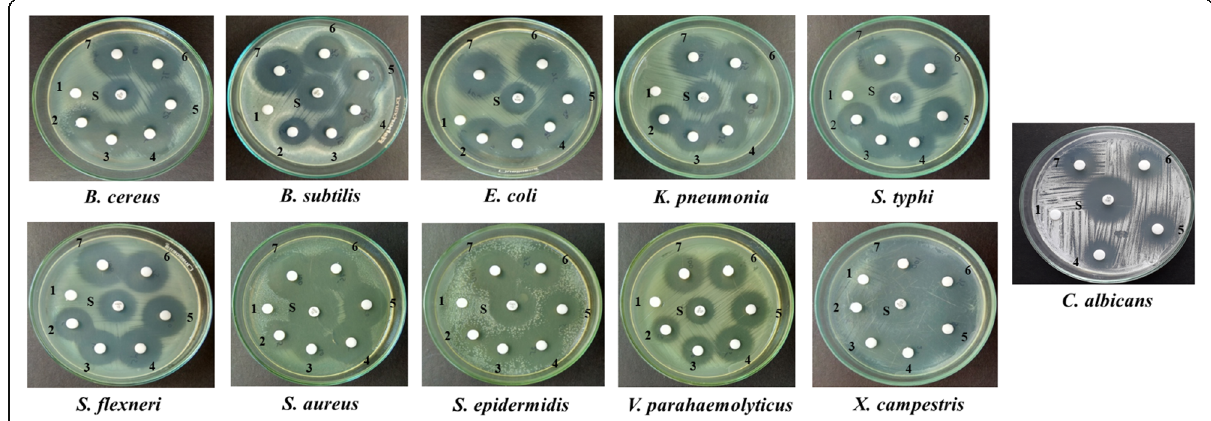
Fig. 3 Antimicrobial activity of phomalactone isolated from N. sphaerica. NOTE: Standard gentamicin (10 μ g disc -1 ; for bacteria) and nystatin (100 U disc -1 ; for fungus) (S), negative control (1), 30 μ g disc -1 (2), 60 μ g disc -1 (3), 150 μ g disc -1 (4), 300 μ g disc -1 (5), 450 μ g disc -1 (6), and 600 μ g disc -1